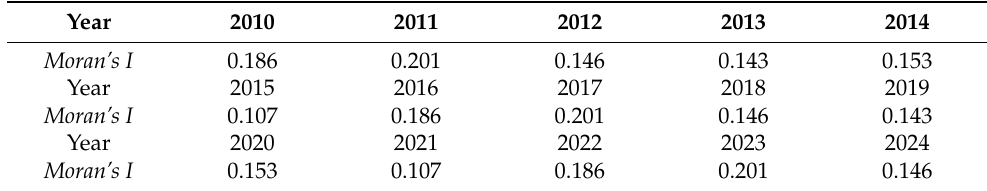
Table 6. Moran’s I index